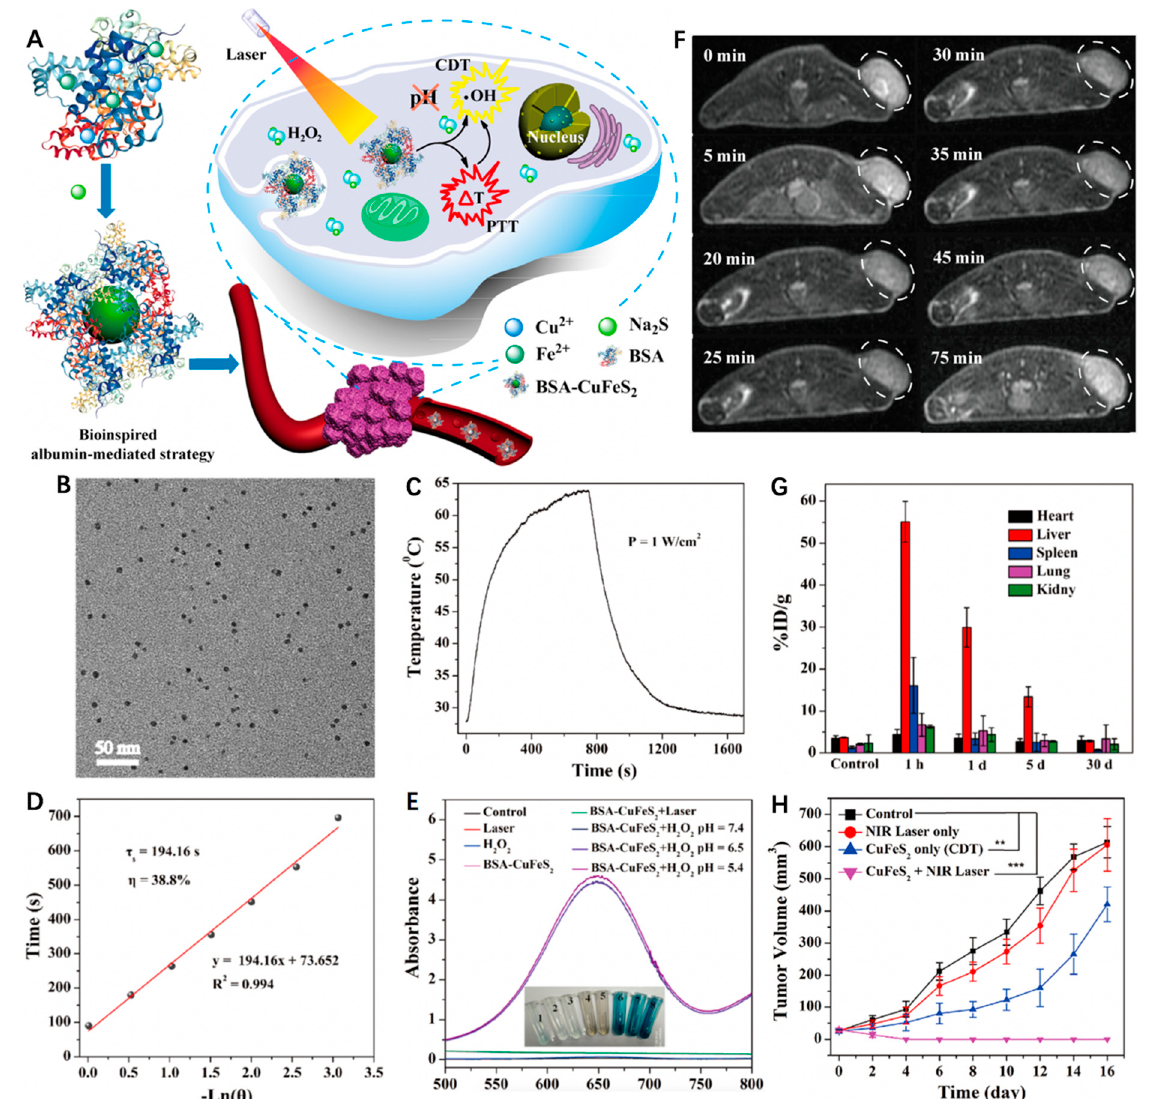
Figure 1. ( A ) Schematic illustrating the synthesis of BSA-CuFeS 2 nanoparticles and their applications for synergetic pH- independent CDT/PTT. ( B ) Transmission electron microscope (TEM) image of the BSA-CuFeS 2 NPs. ( C ) Photothermal effect of the BSA-CuFeS 2 aqueous suspensions ([Cu] = 100 ppm) under irradiation, and then the laser was shut off (808 nm laser, 1 W cm − 2 ). ( D ) Calculation of the time constant ( τ s ) and PCE. ( E ) UV − vis spectra of the 3,3,5,5-tetramethylbenzidine (TMB) aqueous with or without H 2 O 2 or BSA-CuFeS 2 at varying pH values. BSA-CuFeS 2 with H 2 O 2 could catalyze the reaction of TMB to cause a blue color reaction at varying pH conditions with maximum absorbance at 652 nm. Inset: corresponding different color reactions of samples. ( F ) T 2 -weighted MR images of mice bearing transplanted 4T1 tumors injected intravenously with BSA-CuFeS 2 (15 mg kg − 1 ). ( G ) Biodistribution of Cu in the major organs at varying times. ( H ) Tumor growth volume curves after different treatments. Reprinted with permission from Ref. [60]. Copyright 2019, Amer- ican Chemical Society.